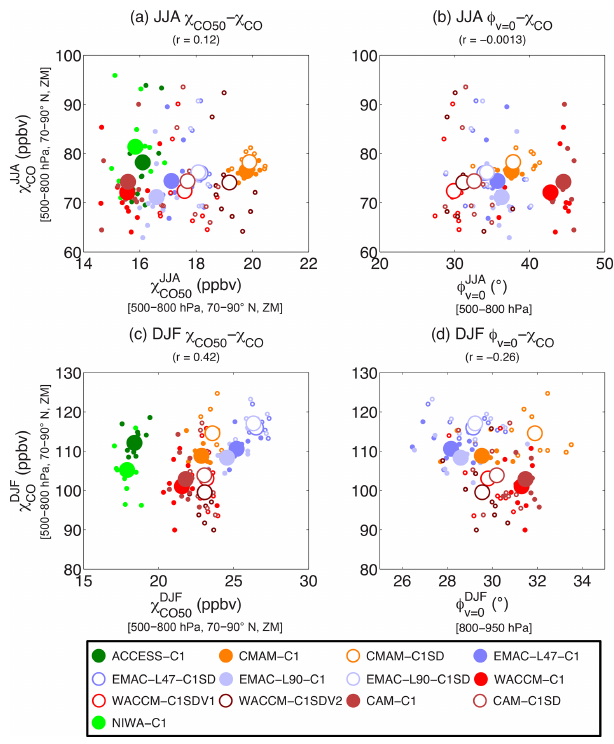
Figure 13. Similar to Fig. 12a, c, e, g, but for correlations: (a, c) be- tween χ CO and χ CO50 and (b, d) between φ v = 0 and χ CO ; during DJF in (a) and (b) and JJA in (c) and (d)